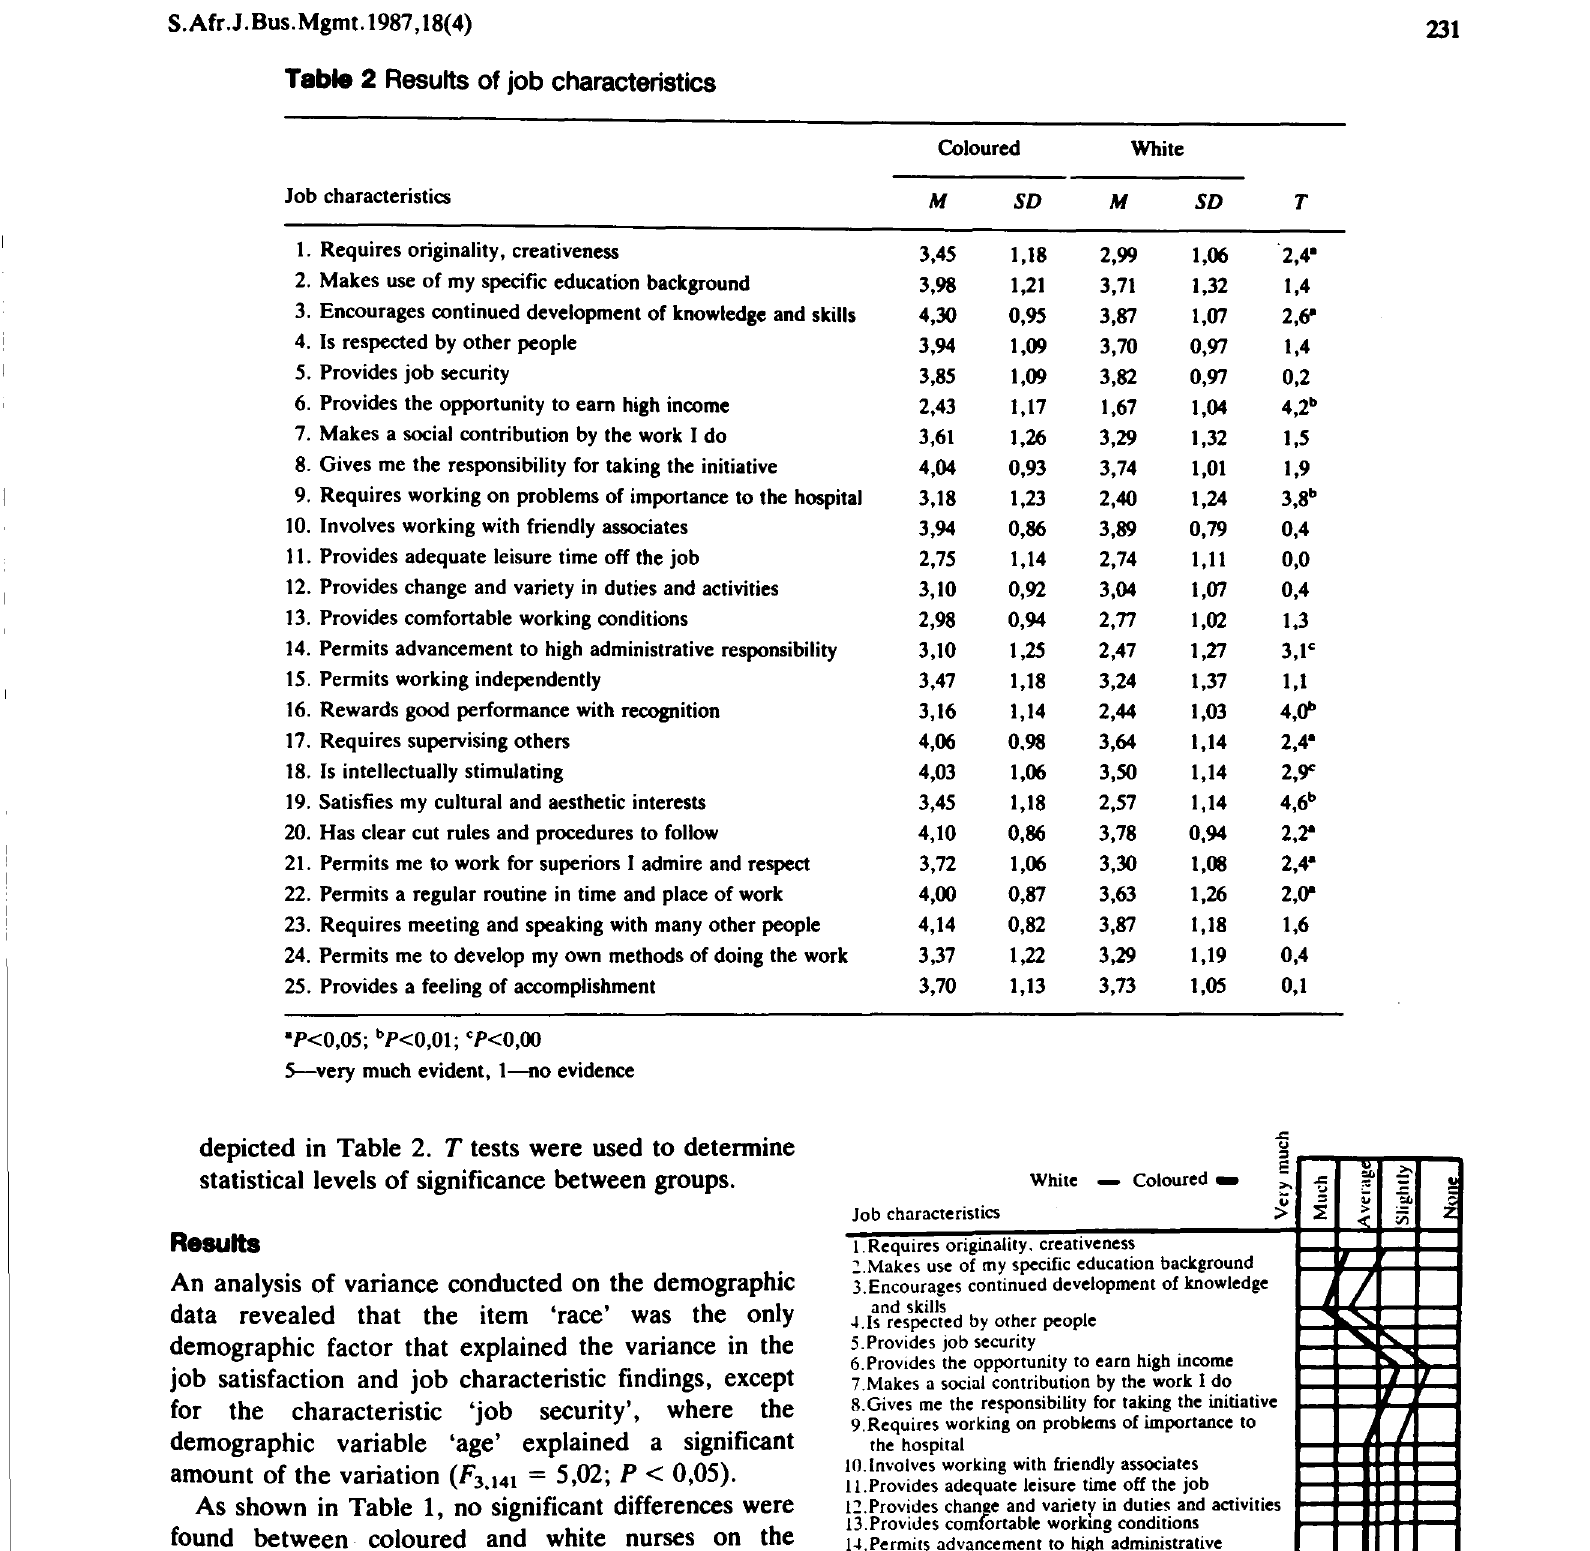
\ LI', Table 2 indicates that coloured nurses perceived great